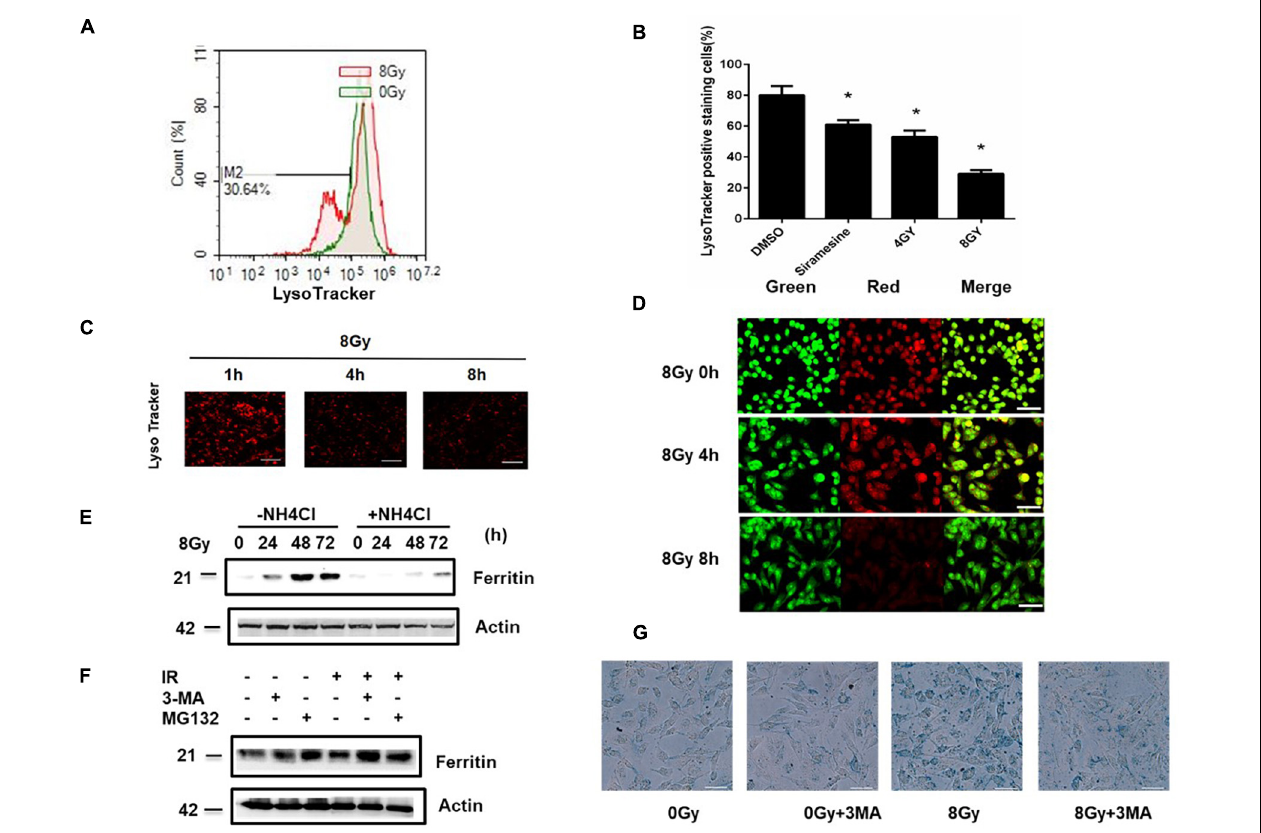
FIGURE 3 | Radiation induced Lysosomal membrane permeabilization (LMP) in MDA-MB-231 breast cancer cells. MDA-MB-231 cells were treated with 4 Gy, 8 Gy radiation respectively, the amount of LMP was detected at 4, 8 h with LysoTracker and analyzed by flow cytometry (A–C) or with AO staining (D) . In the presence or absence of NH 4 Cl, the Ferritin (FTH) expression were detected after 8 Gy treatment at 24 h (E) . Cells were pretreated with 3MA (2 mM) or MG132 (1 µ M) for 1 h before 8 Gy radiation, the Ferritin (FTH) expression were detected at 24 h (F) . Cells were pretreated with 3MA before 8 Gy radiation, the intracellular iron was evaluated with Prussian blue staining at 24 h by light microscopy (G) . These results were representative of three independent experiments and expressed as means ± SD. P -values were calculated using repeated measure ANOVA with P < 0.05 being considered as statistical significance, * P <